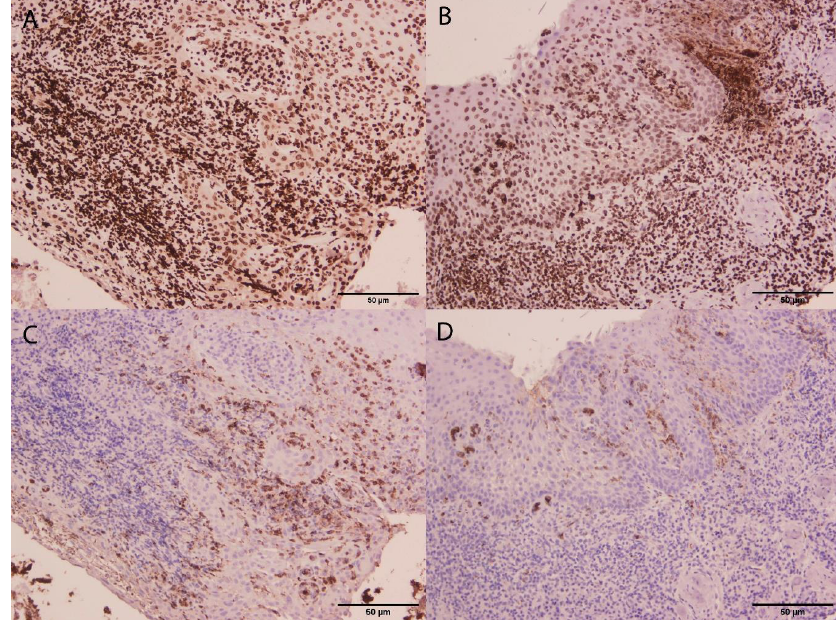
Figure 2. Micrographs from gingivitis ( A , C ) and periodontitis ( B , D ) gingival tissue samples. Immunostaining of citrullinated histone H3 ( A , B ) and MPO ( C , D ) are shown. Although